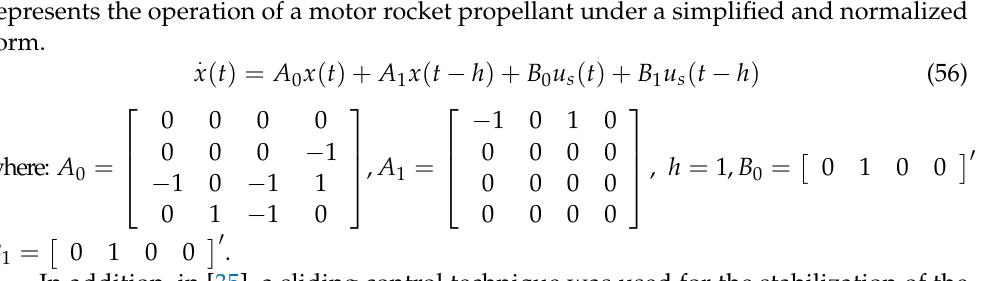
Figure 9. Evolution of the states with 01.0